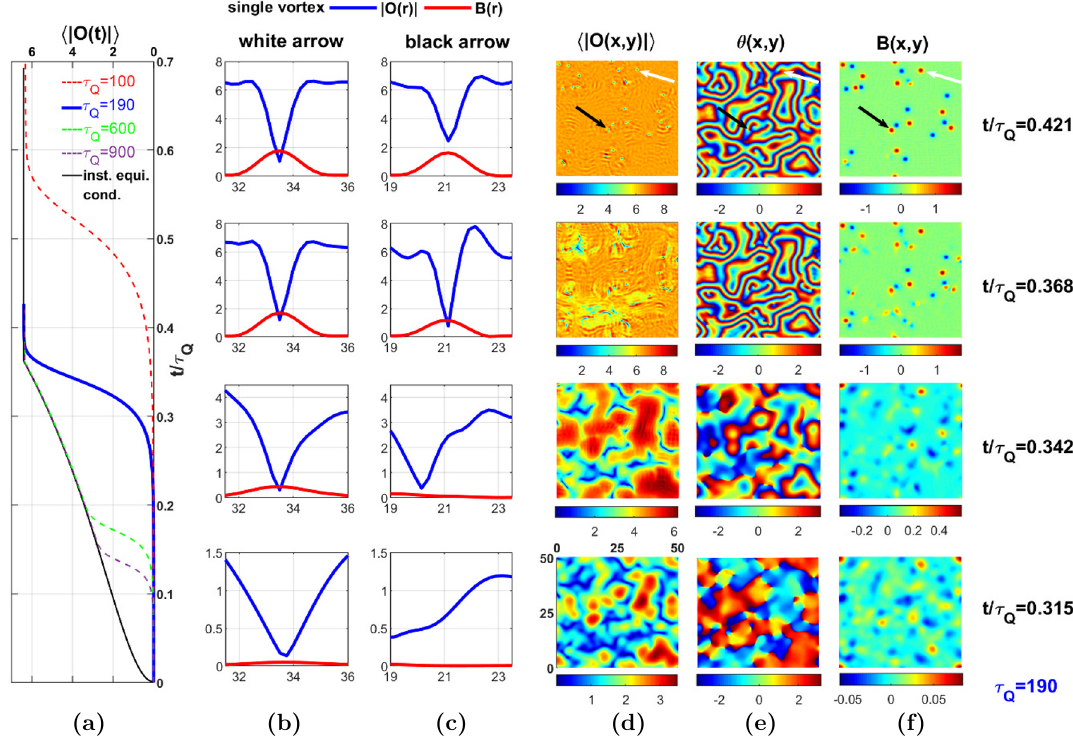
Figure 2. Time evolution of the order parameter and the birth of topological defects. (a) The average absolute value of the order parameter h| O ( t ) |i during quenches with τ Q = 100 , 190 , 600 and 900 . Quenches end at final temperature T f = 0 . 64 T c . The black solid line is the instantaneous equilibrium value of the average condensate. Explicit examples of order parameter and magnetic field for τ Q = 190 (thick blue) are shown in the panels (b)-(f) . (b) & (c) Snapshots of the cross sections of condensate and magnetic fields for a single vortex at four specific times with τ Q = 190 . Their locations are indicated by the white and black arrows respectively in the subsequent panels (d) - (f) . Blue curves are the profiles of the order parameter while red curves are the magnetic fields. (d), (e) & (f) Density plots of the order parameter h| O ( x, y ) |i , phases of the order parameter θ ( x, y ) and the corresponding magnetic field B ( x, y ) at four specific times with τ Q = 190 , respectively.